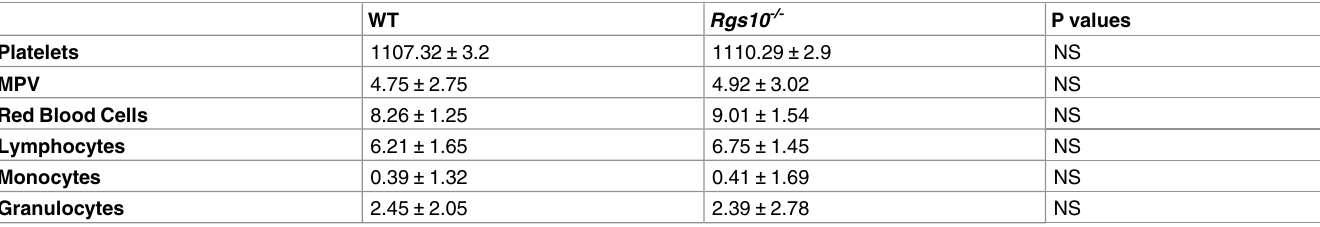
Table 1. Peripheral blood cell counts in WT and Rgs10 -/- mice. WT Rgs10 -/- P